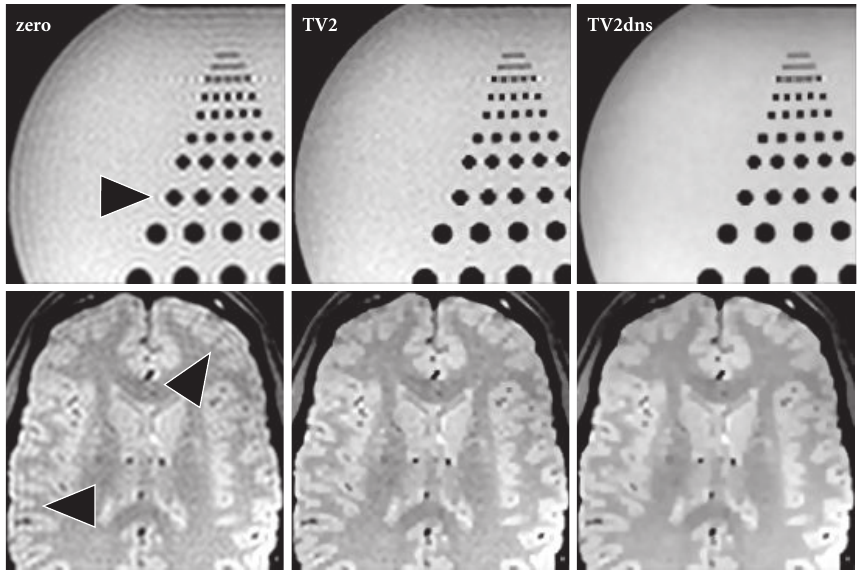
Figure 6: Spin-echo images of (top) a phantom (TR/TE = 4000/100 ms, BW 789 Hz/pixel, FA 50 ◦ , 1mm slice) and (bottom) a human brain in vivo (TR/TE = 4000/15 ms, BW 401 Hz/pixel, FA 70 ◦ , 1mm slice) reconstructed from noisy data (96 × 96 samples, 288 × 288 reconstruction matrix) using zero-padding (zero), the proposed extrapolation method (TV2), and the proposed method combined with denoising (TV2dns). Arrows = truncation